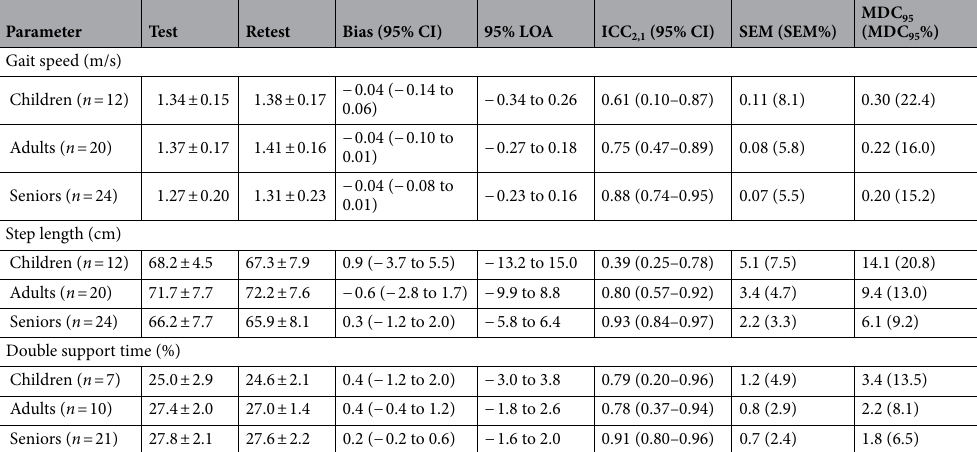
Table 3. Test–retest reliability of the Health app. Descriptive data given as mean ± standard deviation. CI confidence interval, LOA limits of agreement, ICC intraclass correlation coefficient, SEM standard error of measurement, MDC minimal detectable